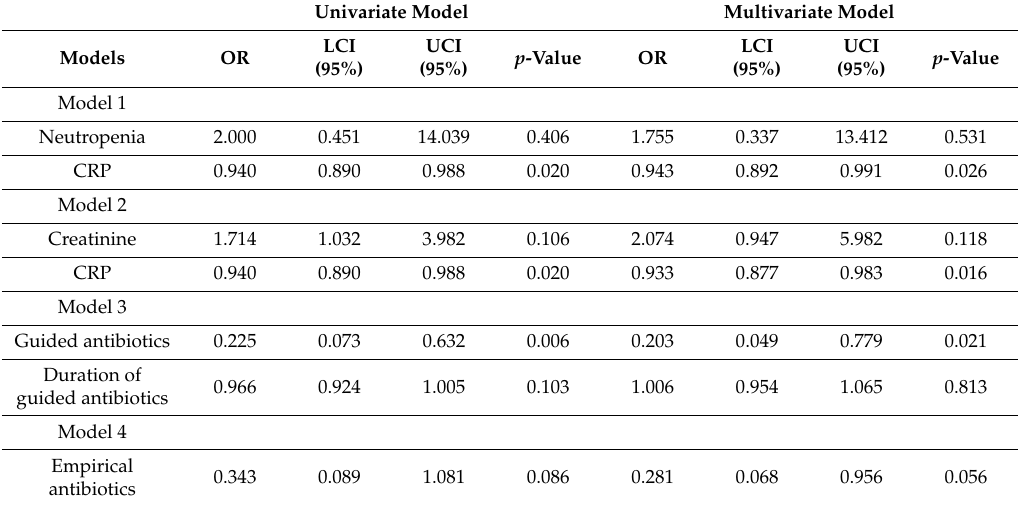
Table 4. Models with statistically significant results in univariate and multivariate